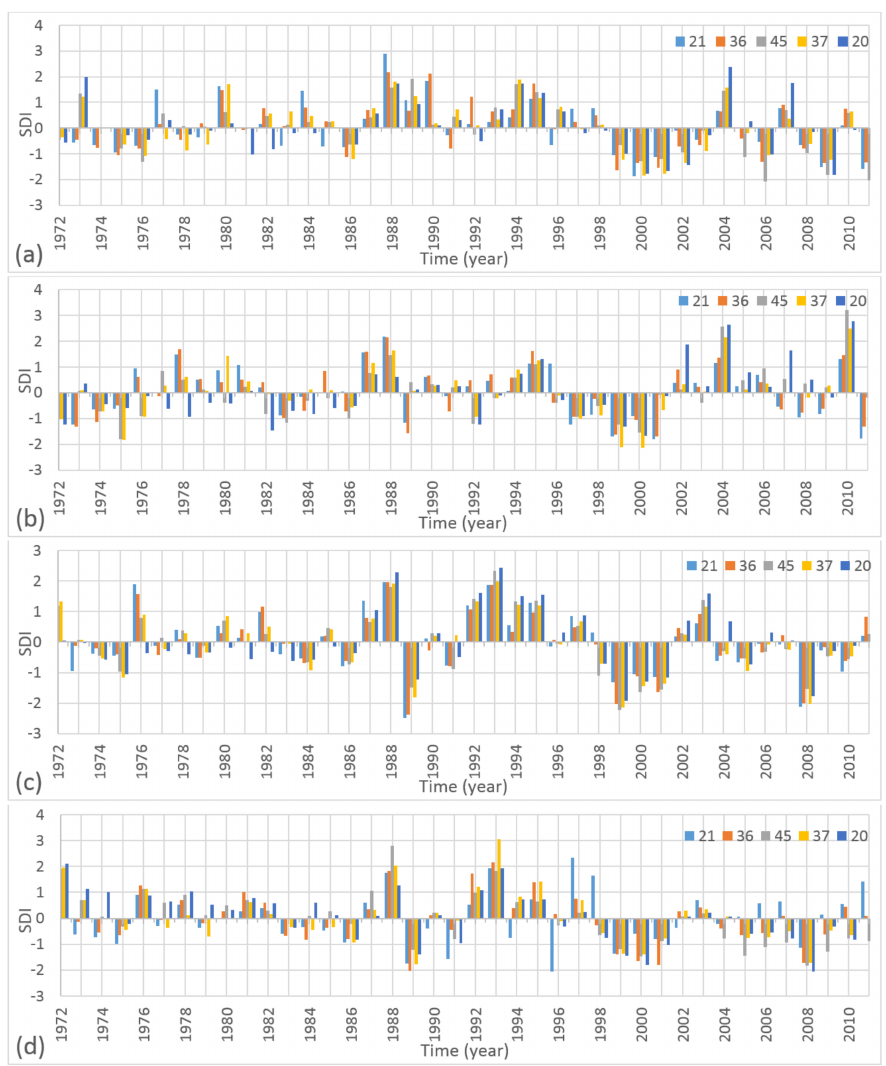
Figure 6. SDI-3 series of the stations 21, 36, 45, 37, and 20 for the periods ( a ) October–December, ( b ) January–March, ( c ) April–June, and ( d )